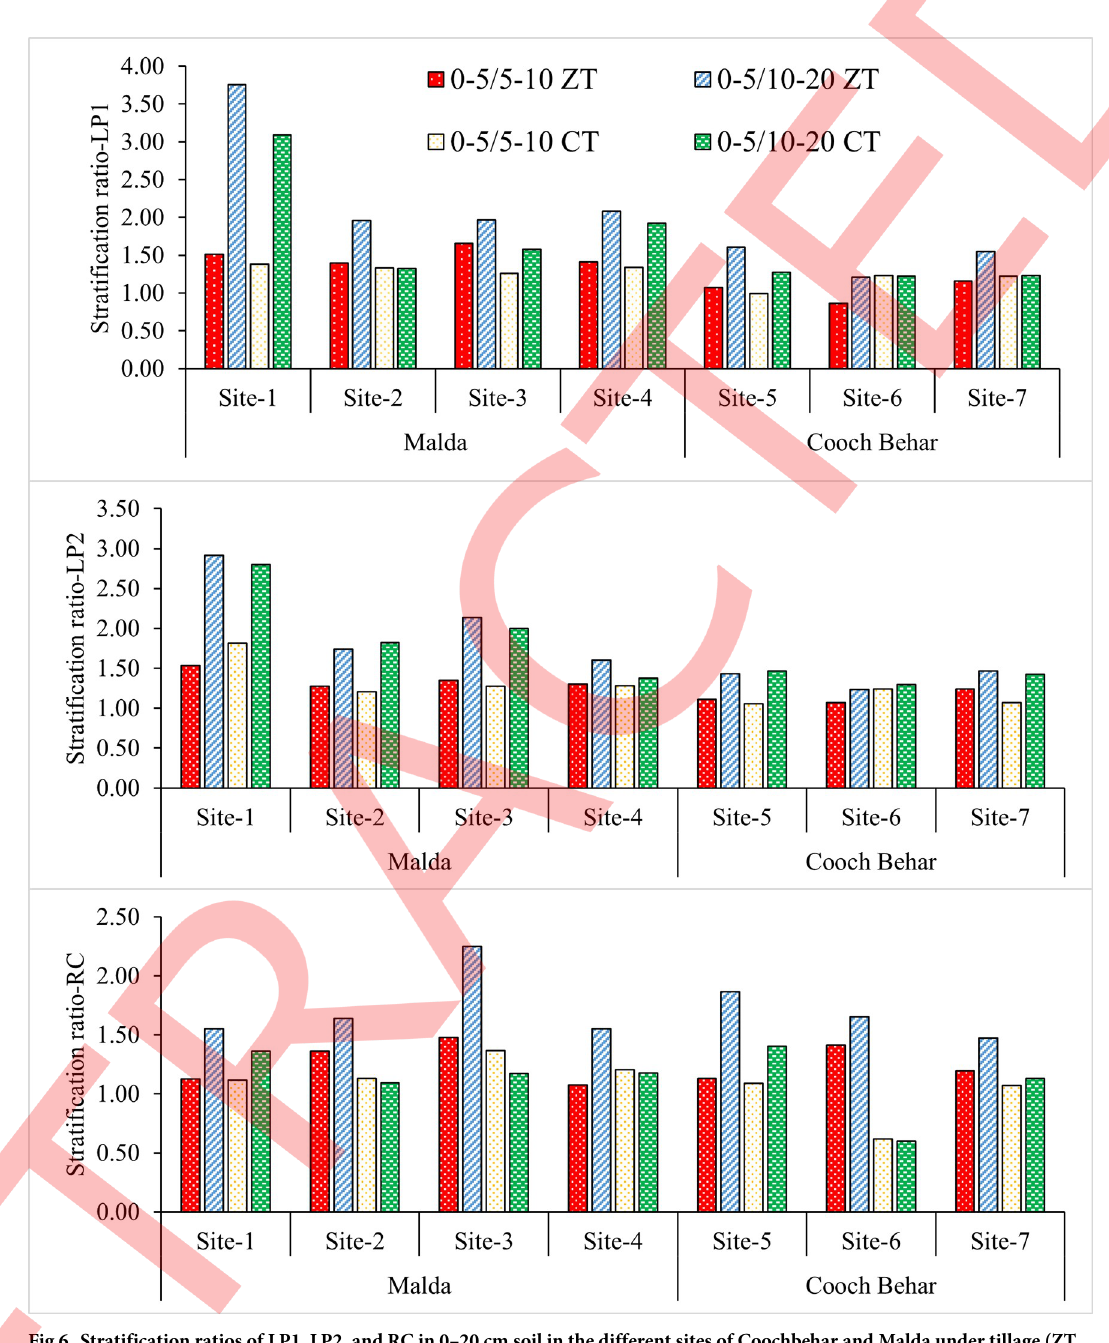
Fig 6. Stratification ratios of LP1, LP2, and RC in 0–20 cm soil in the different sites of Coochbehar and Malda under tillage (ZT and CT) systems.